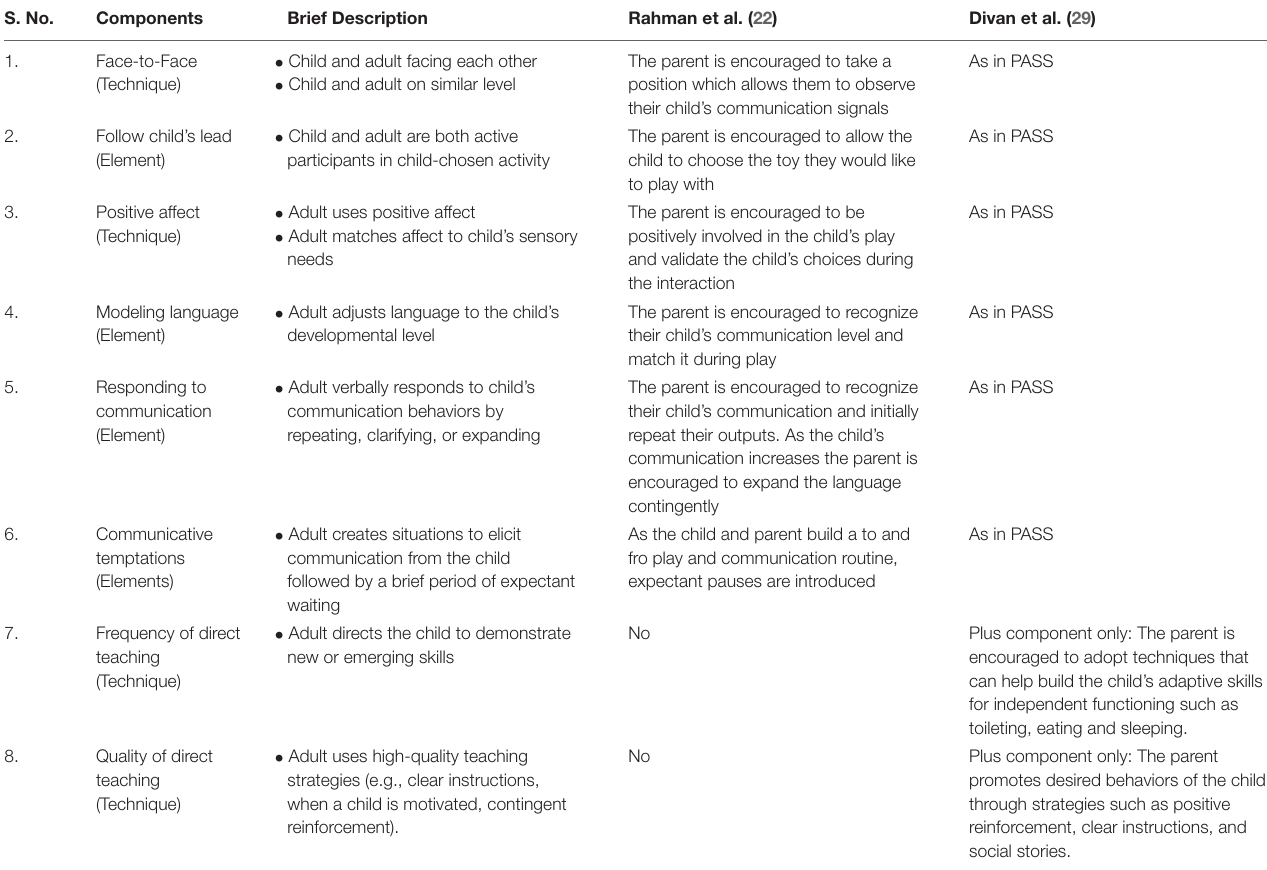
TABLE 5 | List of common components based on the NDBI-Fi framework (11). S.